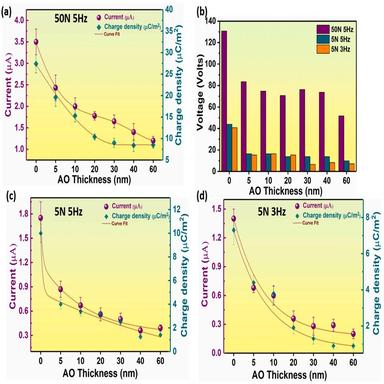
Triboelectric response of PA6 and AO contact electrification under different conditions (a) current and charge density obtained in AO/PA6 device at 50 N and 5 Hz (b) Voltage response under all the three conditions (c) current and charge density obtained in AO/PA6 device at 5 N and 5 Hz (d) current and charge density obtained in AO/PA6 device at 5 N and 3 Hz (Note: the line connecting points (in figures a–c) are only for representation purpose).